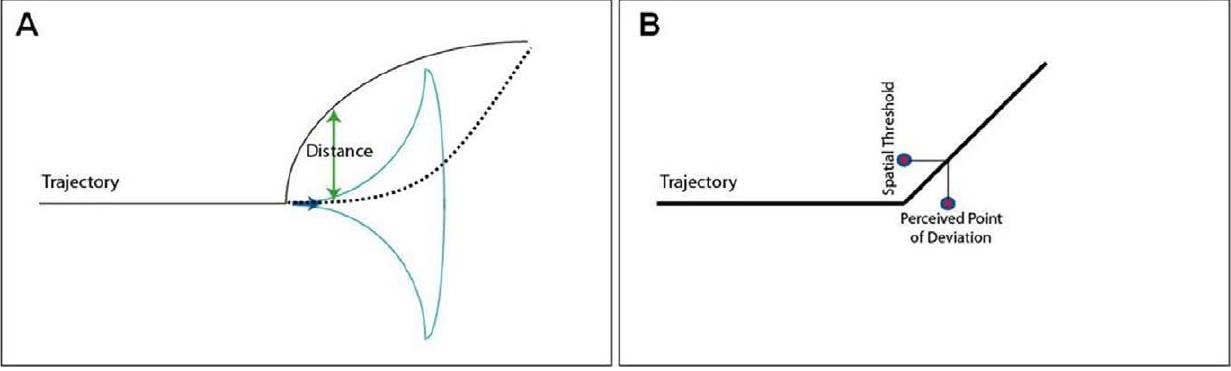
Figure 8. Trajectories with small and large exponents, and spatial threshold calculation from perceived point of deviation. A. Trajectory for a small exponent is shown by the solid curve and for a large exponent by the dashed curve. The motion-anticipation is shown as a cone. The cone will not effectively shift the trajectory with the small exponent because of the large distance between them and large exponent trajectory because of the smooth transition in direction. B. Estimating the spatial deviation threshold. The ordinate of the trajectory at the perceived point of deviation represents the inferred spatial threshold for detecting the deviation. This is illustrated for a bilinear trajectory.